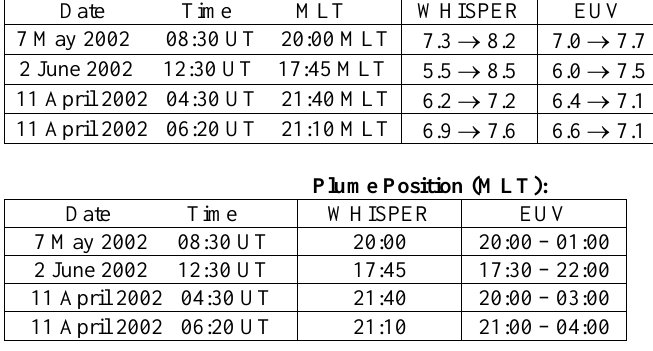
Table 3. Comparison between WHISPER and EUV for the three events about the plasmapause position.